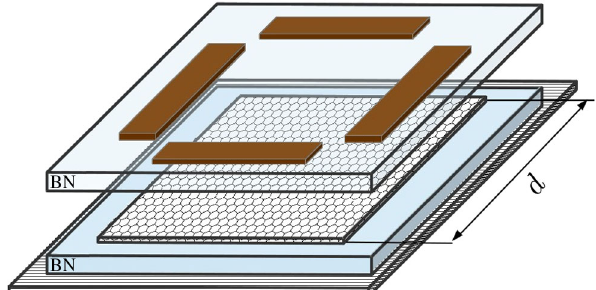
FIG. 15. An exploded view of a sandwich structure, based on the capabilities recently reported in Ref. [62]. A graphene flake is encapsulated between two layers of insulating boron nitride (BN). Four edge electrodes grown above the structure as shown could serve as the four capacitive contacts of the two-port